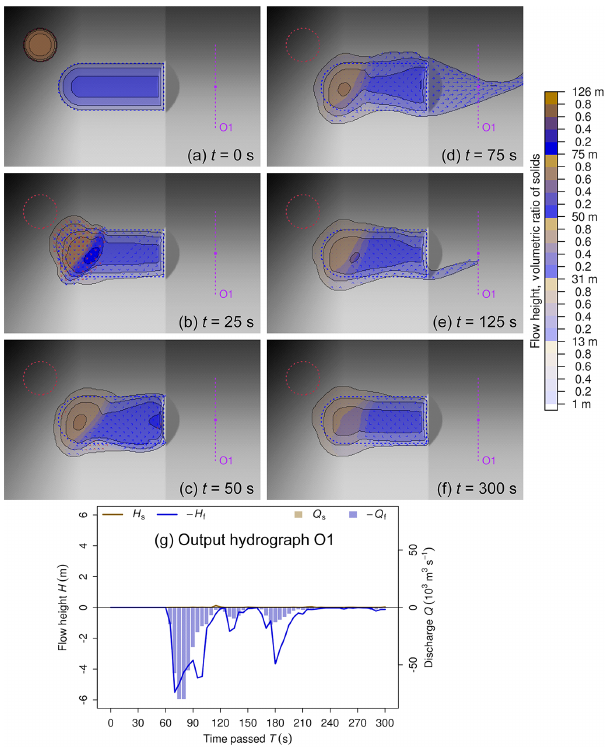
Figure 6. Key results of Experiment 1A. (a–f) Sequence of sim- ulated flow heights and solid ratios at selected points of time; see Animation 1A in the Supplement for animations of flow height se- quences; (g) output hydrograph O1 (see Fig. 5a).